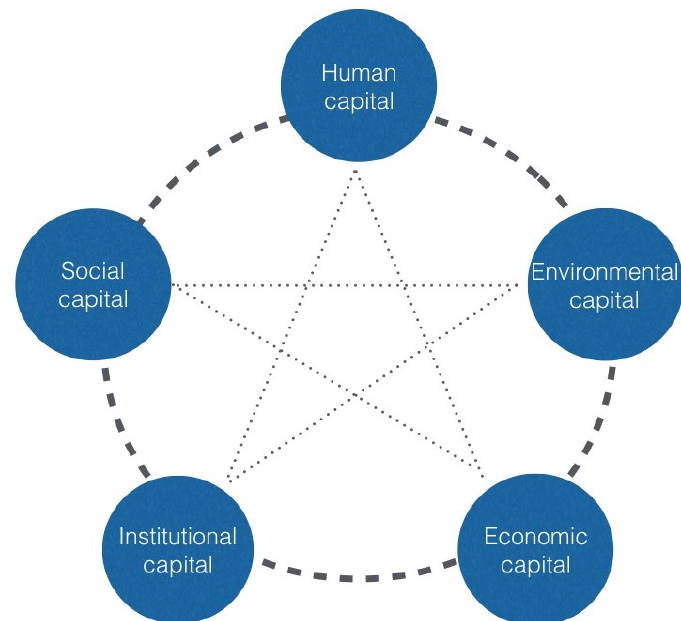
Figure 1 Five drivers of resilience. (Source: Author adaptation based on the five sustainable development capitals). 14